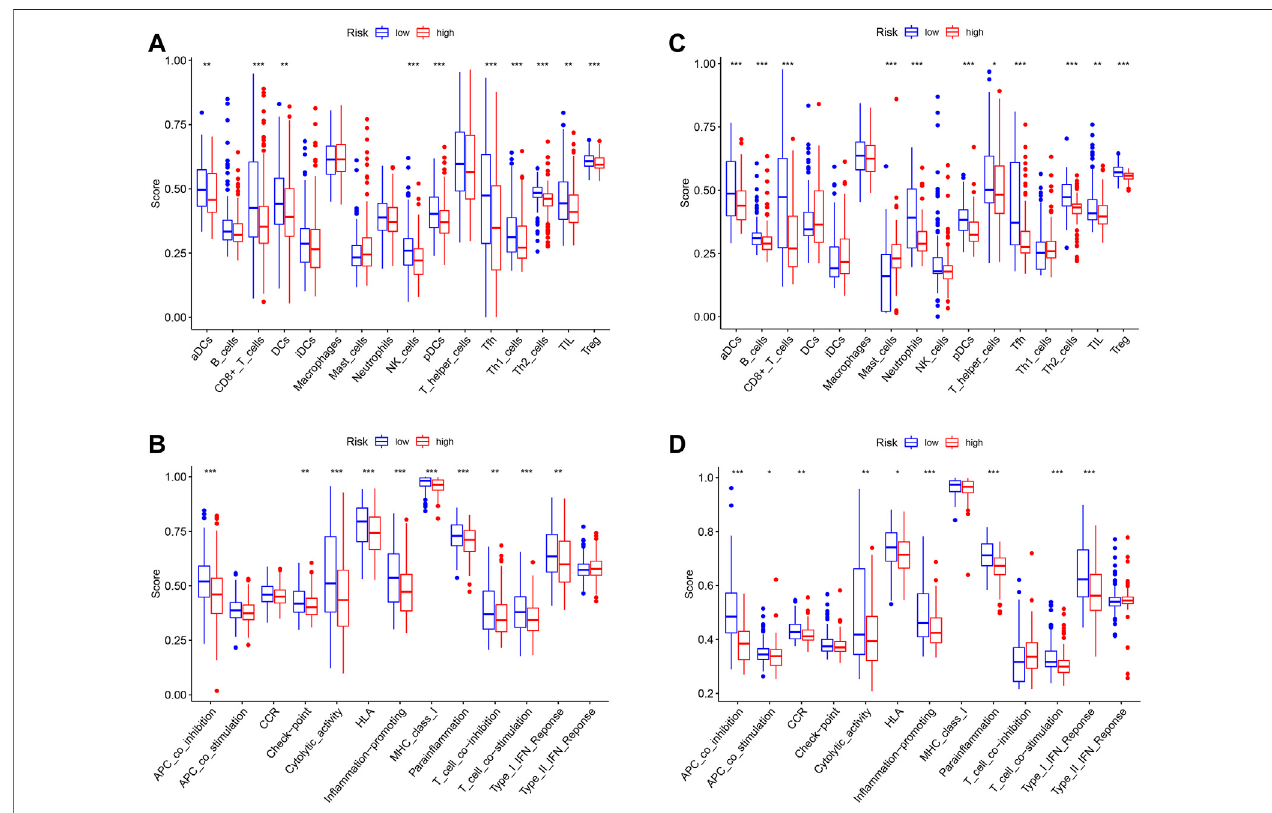
FIGURE 8 | (A) Enrichment levels of 16 tumor-in fi ltrating immune cells in high- and low-risk groups from TCGA data. (B) Enrichment levels of 13 immune-related pathways in high- and low-risk groups from TCGA data. (C) Enrichment levels of 16 tumor-in fi ltrating immune cells in high- and low-risk groups from GEO data. (D) Enrichment levels of 13 immune-related pathways in high- and low-risk groups from GEO